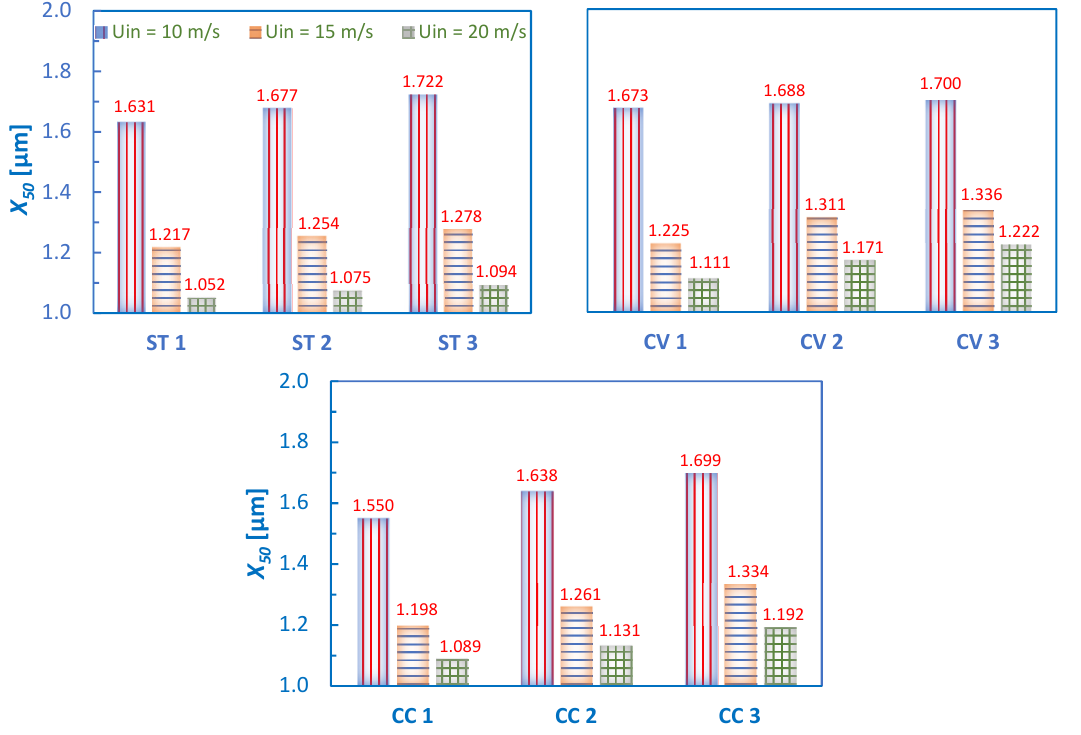
Figure 9. Cut-off sizes in all cyclone models of ST variant, CV variant, and CC variant at inlet velocities U in = 10, 15 and 20 m/s.